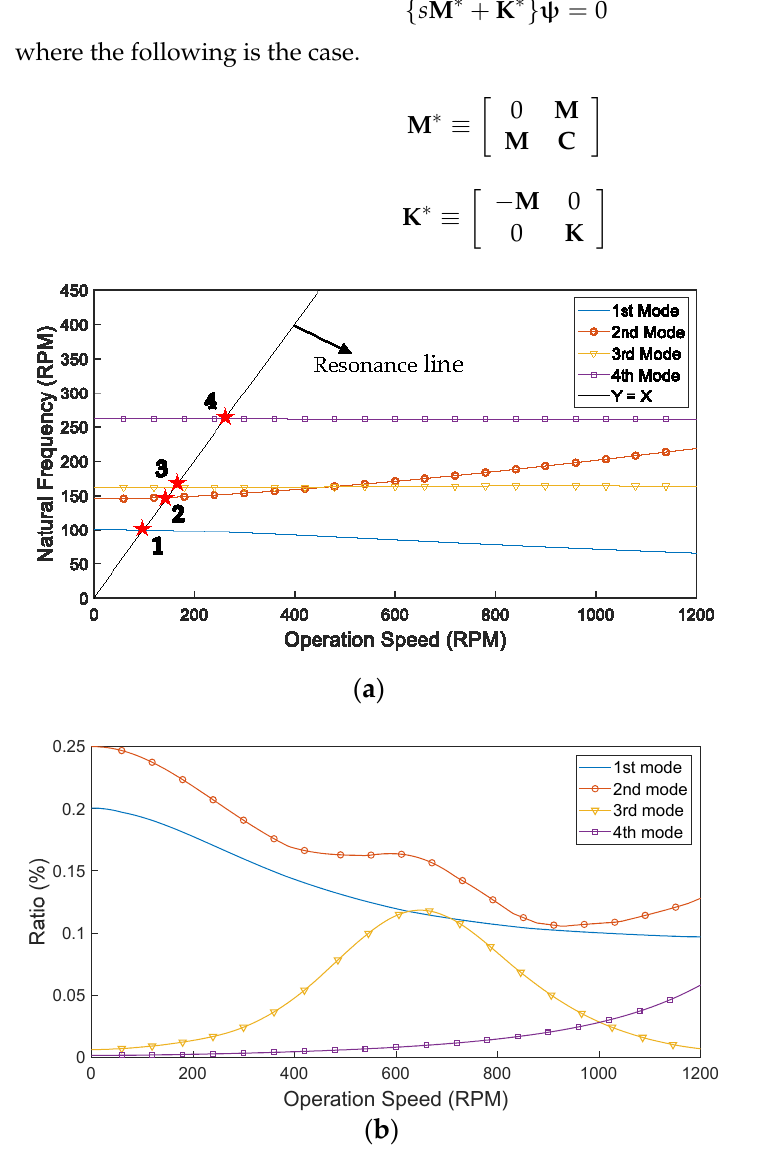
Figure 7. Lowest four natural frequencies and their maximum variations versus operation speed: ( a ) lowest four natural frequencies with resonance line and ( b ) maximum variations of the lowest four natural frequencies.